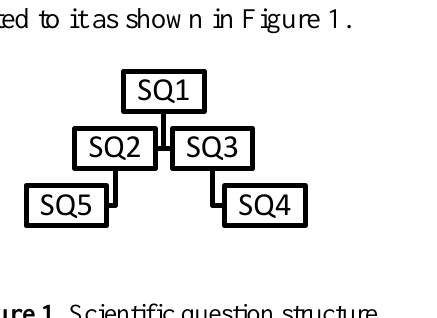
Figure 1. Scientific question